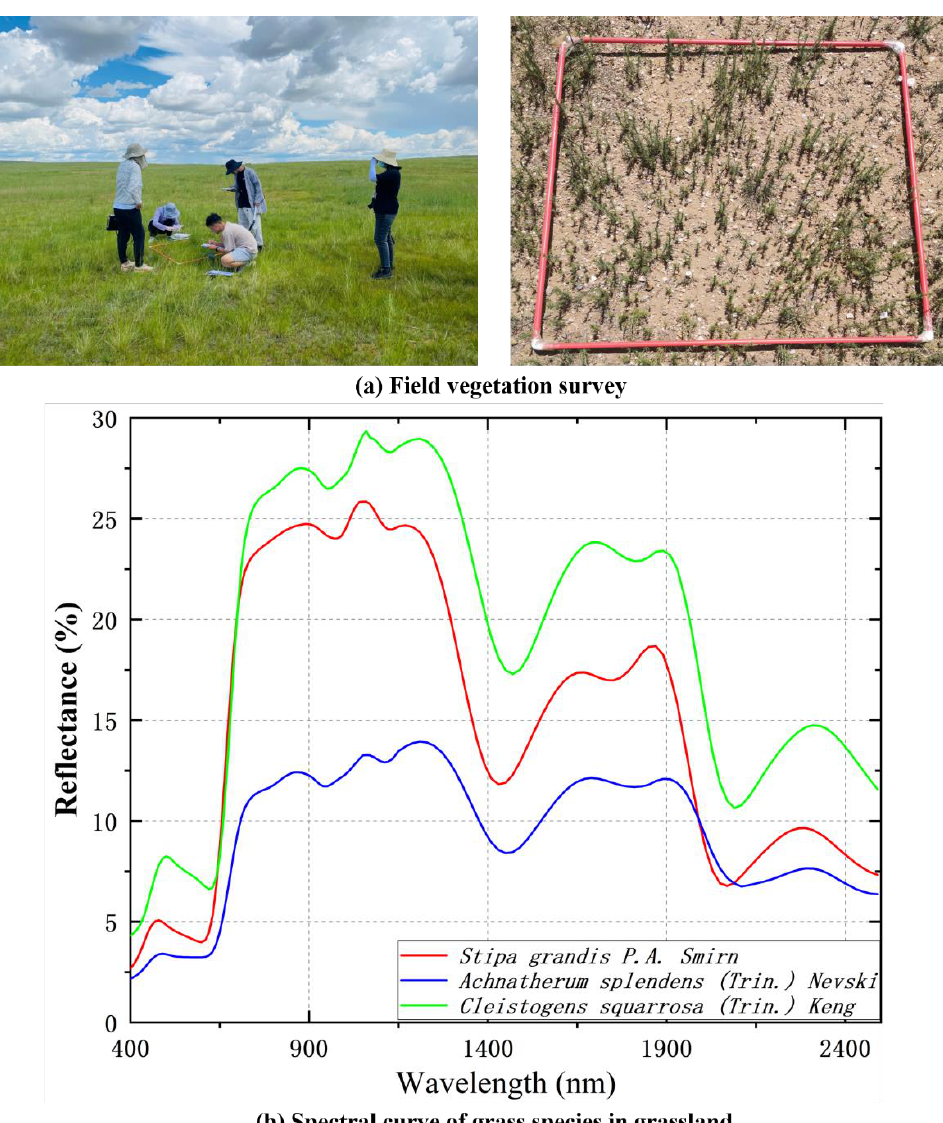
Figure 2. ( a ) Field vegetation survey. ( b ) Spectral curve of grass species in grassland.